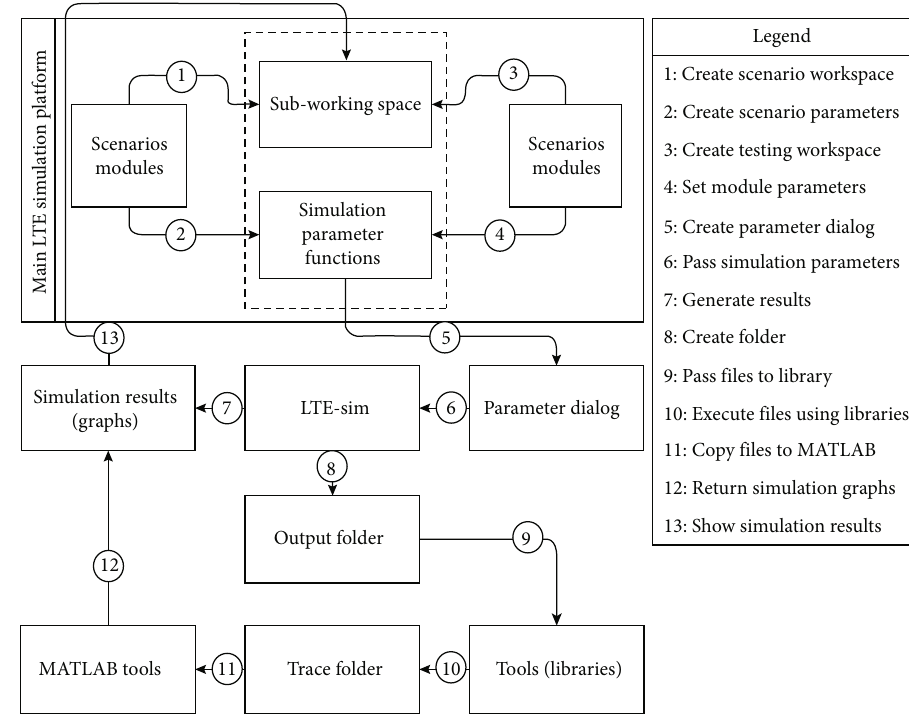
Figure 2: Context diagram of the proposed